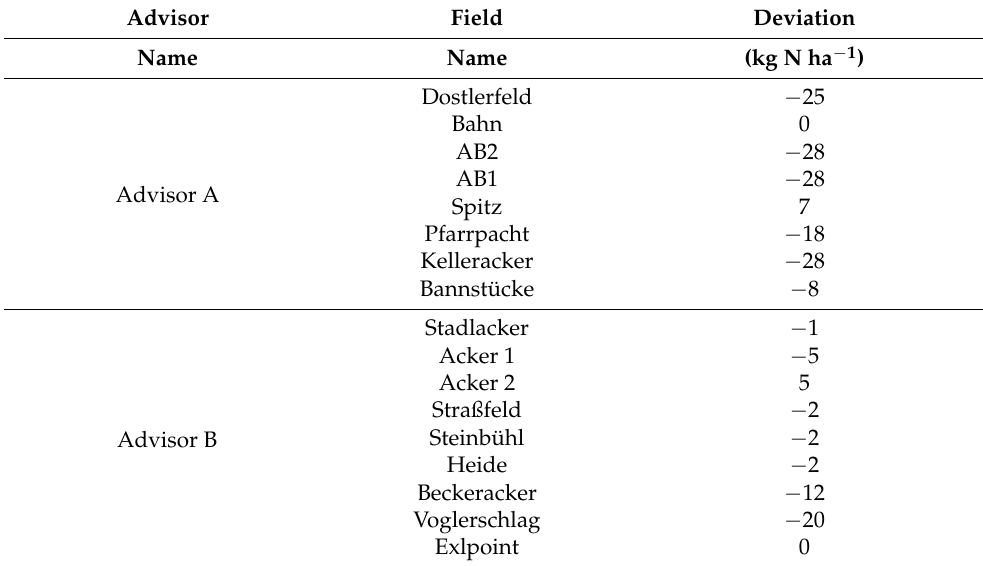
Table 4. Deviation of the DSS tailored by advisor B for recommendations for the 1st RoA in kg N ha − 1 in comparison to the recommendations of advisor A and advisor